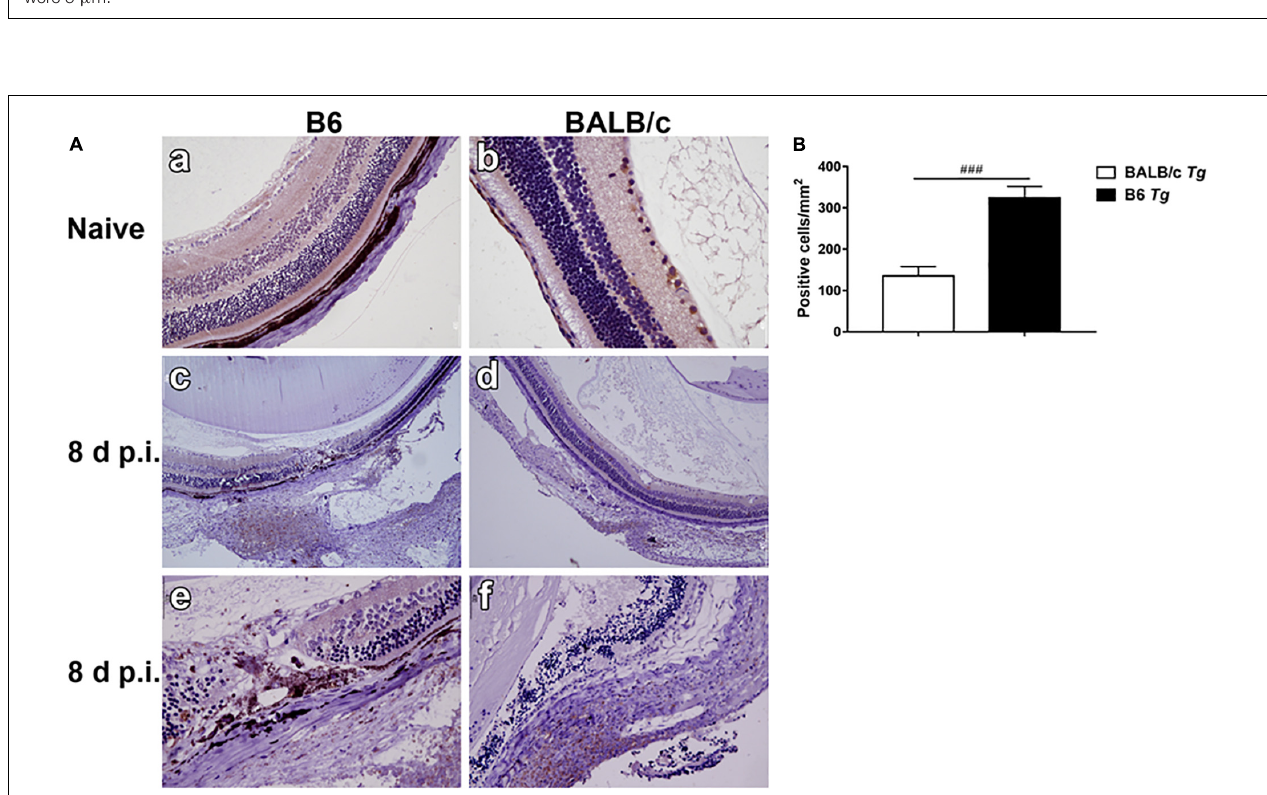
FIGURE 3 | The expression of neutrophil elastase-positive cells in the eyes by immunohistochemical staining (A) . Shown are the eyes of an uninfected B6 mouse (a) and an uninfected BALB/c mouse (b) . At day 8 p.i., there were more neutrophil infiltration in the eyes of T. gondii -infected B6 mice (c,e) than those in T. gondii -infected BALB/c mice (d,f) . The original magnification, a and b 200 × ; c and d 100 × ; e and f 400 × . Quantitative analysis of elastase-positive neutrophil (B) . The density of positive cells was expressed as the number of cells per square millimeter. Data are presented as means ± SD; there were six mice in each group and the data represents from two experiments. ### P < 0.001, T. gondii -infected B6 mice vs. T. gondii -infected BALB/c mice.